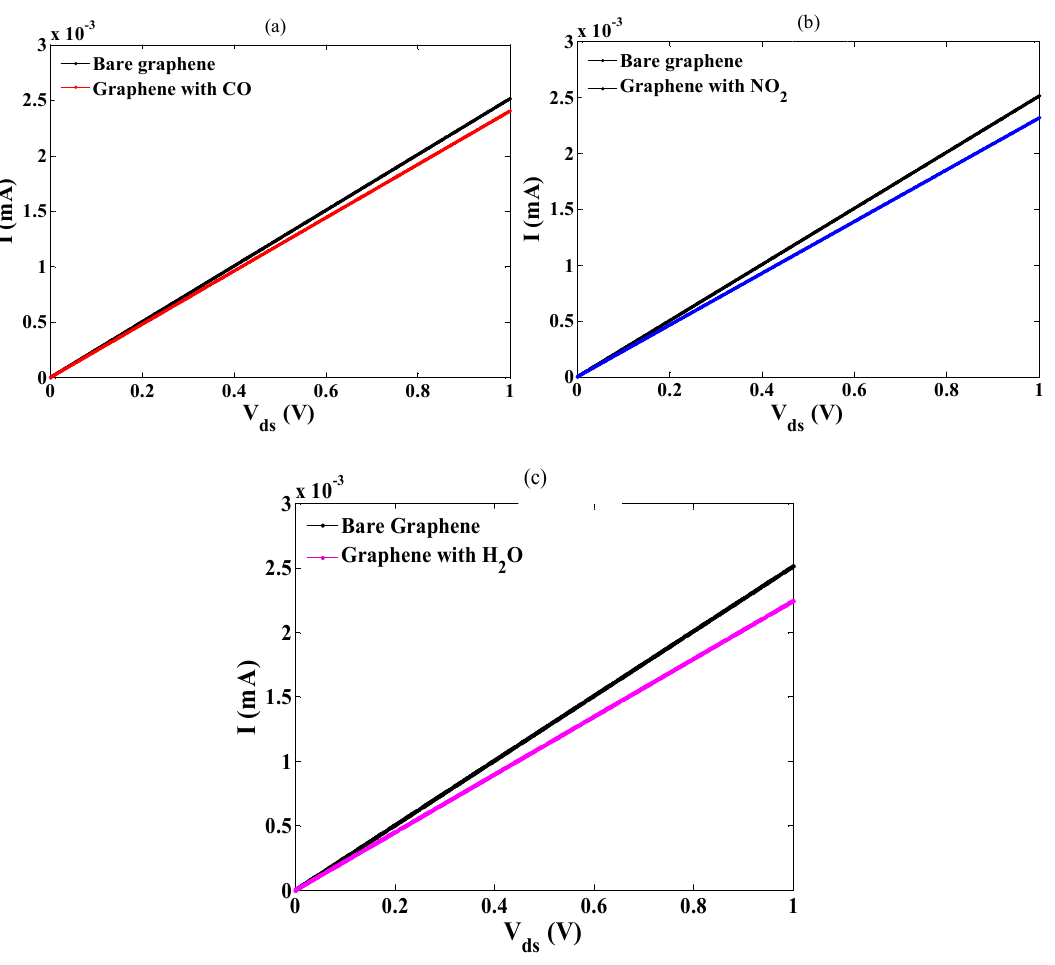
Figure 8. The I-V analysis of the gas sensor after ( a ) CO adsorption; ( b ) NO 2 adsorption; ( c ) H 2 O adsorption.